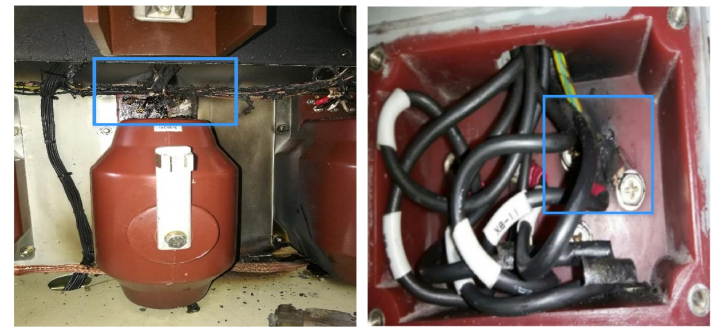
Figure 2. Damaged VT. Figure 2. Damaged